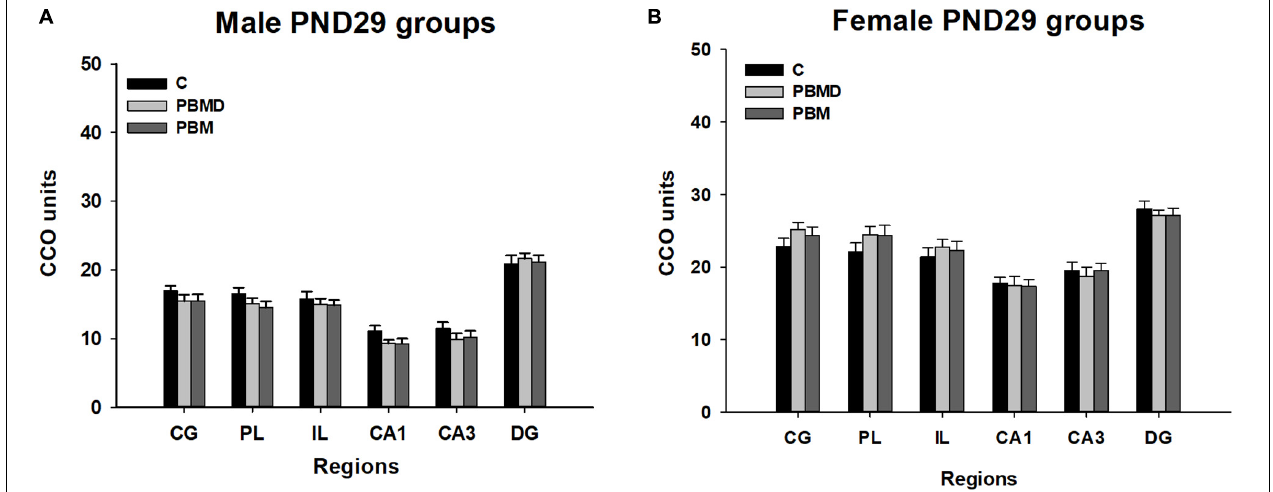
FIGURE 1 | CCO results (mean ± SEM). (A) CCO values in 29-day-old male groups (PBM, PBMD, C). There were no differences between the groups in the assessed areas ( p > 0.05). (B) CCO values in 29 day-old female groups (PBM, PBMD, C). No significant differences were found in any of the areas ( p > 0.05). Groups: C, control group; PBMD, photobiomodulation device group; PBM, photobiomodulation group. Areas: CG, Cingulate cortex; PL, Prelimbic cortex; IL, Infralimbic cortex; CA1, field CA1 of hippocampus; CA3, field CA3 of hippocampus; DG, Dentate Gyrus. PND, postnatal day; CCO, cytochrome c oxidase.